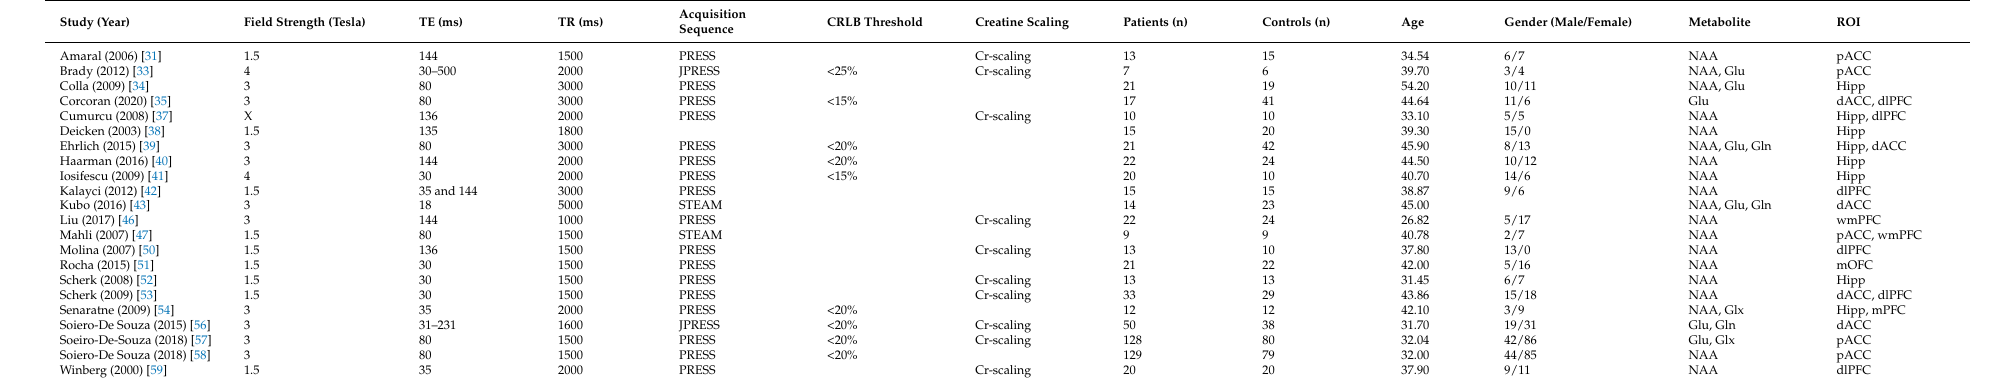
Table 1. Characteristics of studies including BD patients in clinical remission.